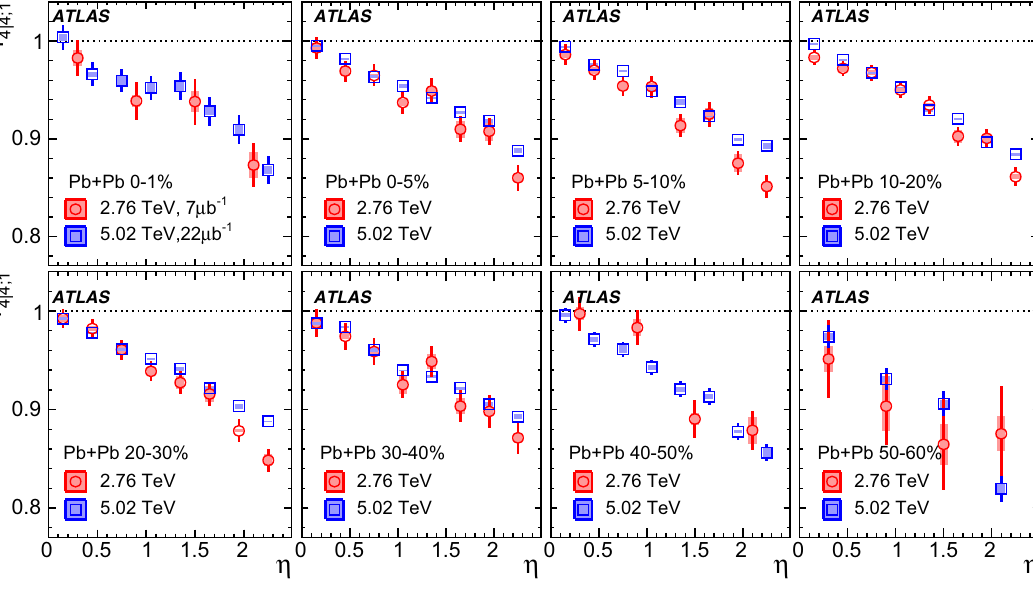
state. The rate of the decrease is also observed to be slightly stronger at lower collision